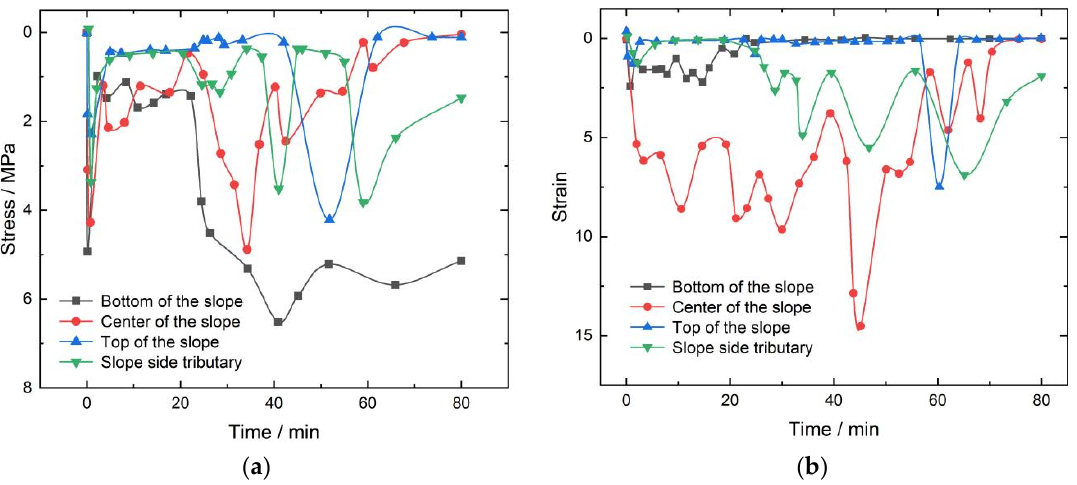
Figure 19. Real-time stress–strain curves. ( a ) stress, ( b ) strain.